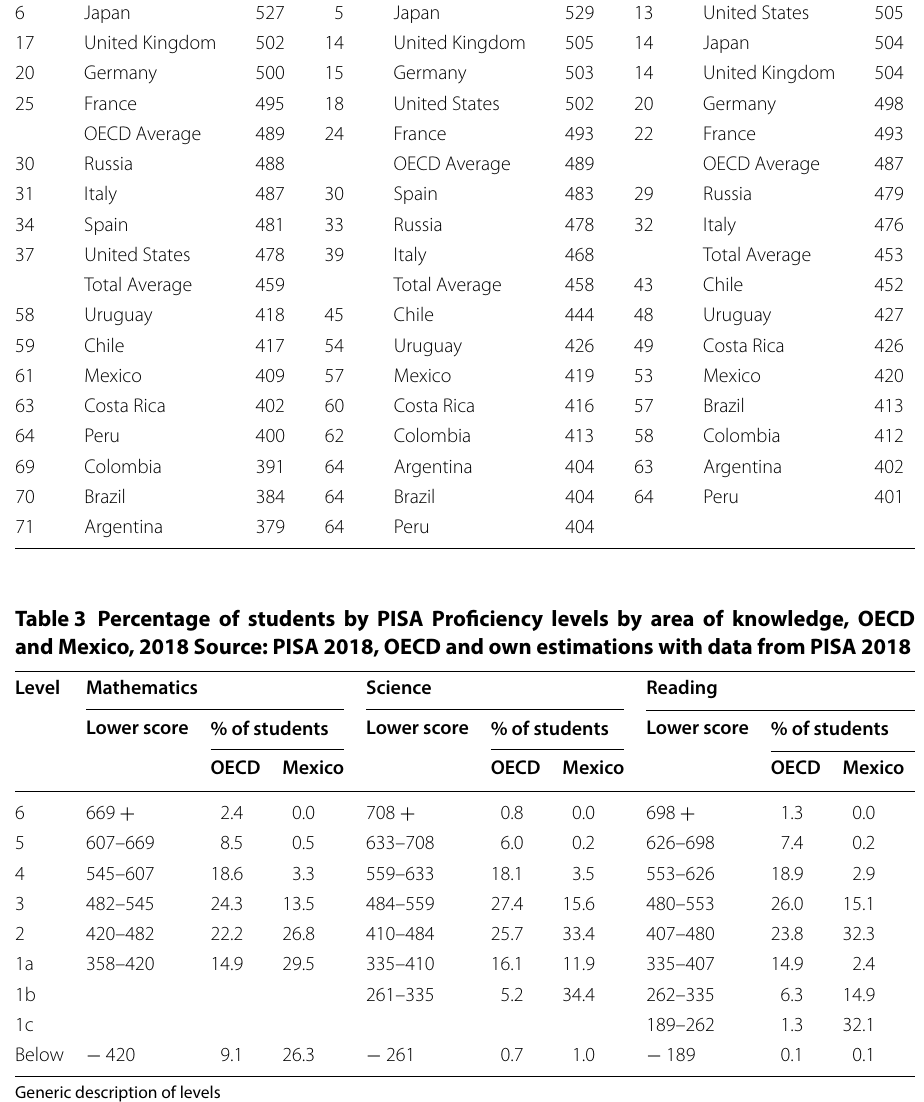
Generic description of